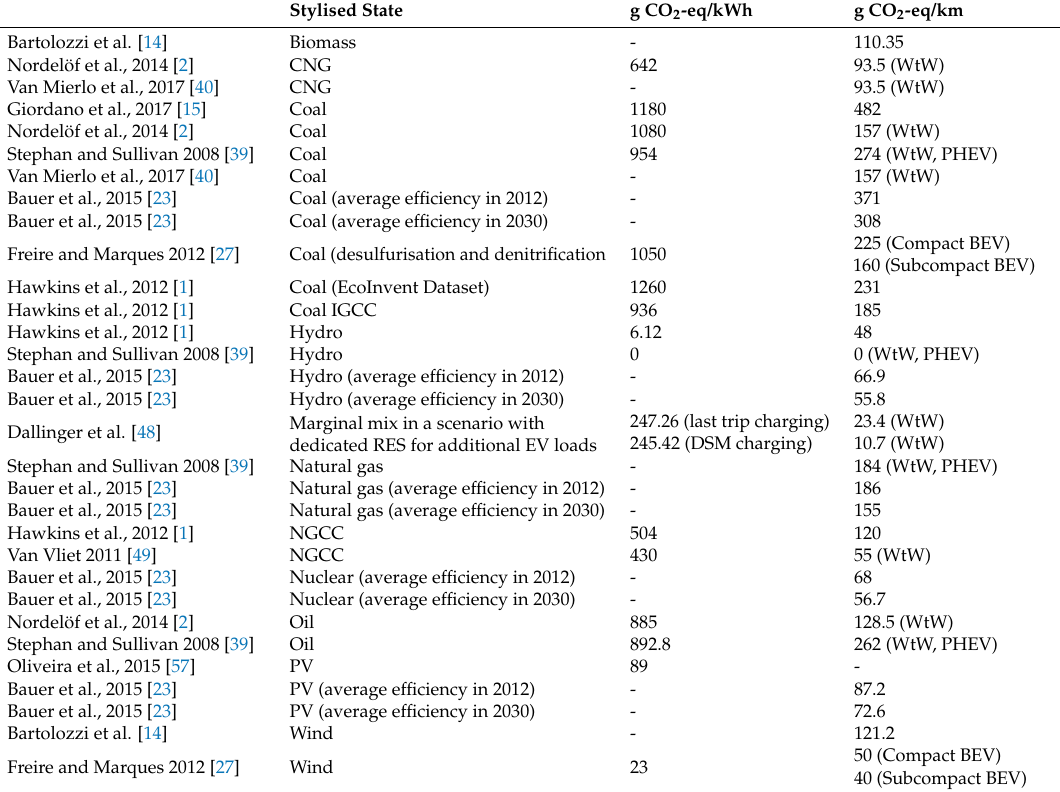
Figure 6. Number of stylised states presented in the literature sorted by energy source. Table 3. Energy GHG intensity and GHG of BEV in stylised states across the literature. Stylised State g CO 2 -eq/kWh g CO 2